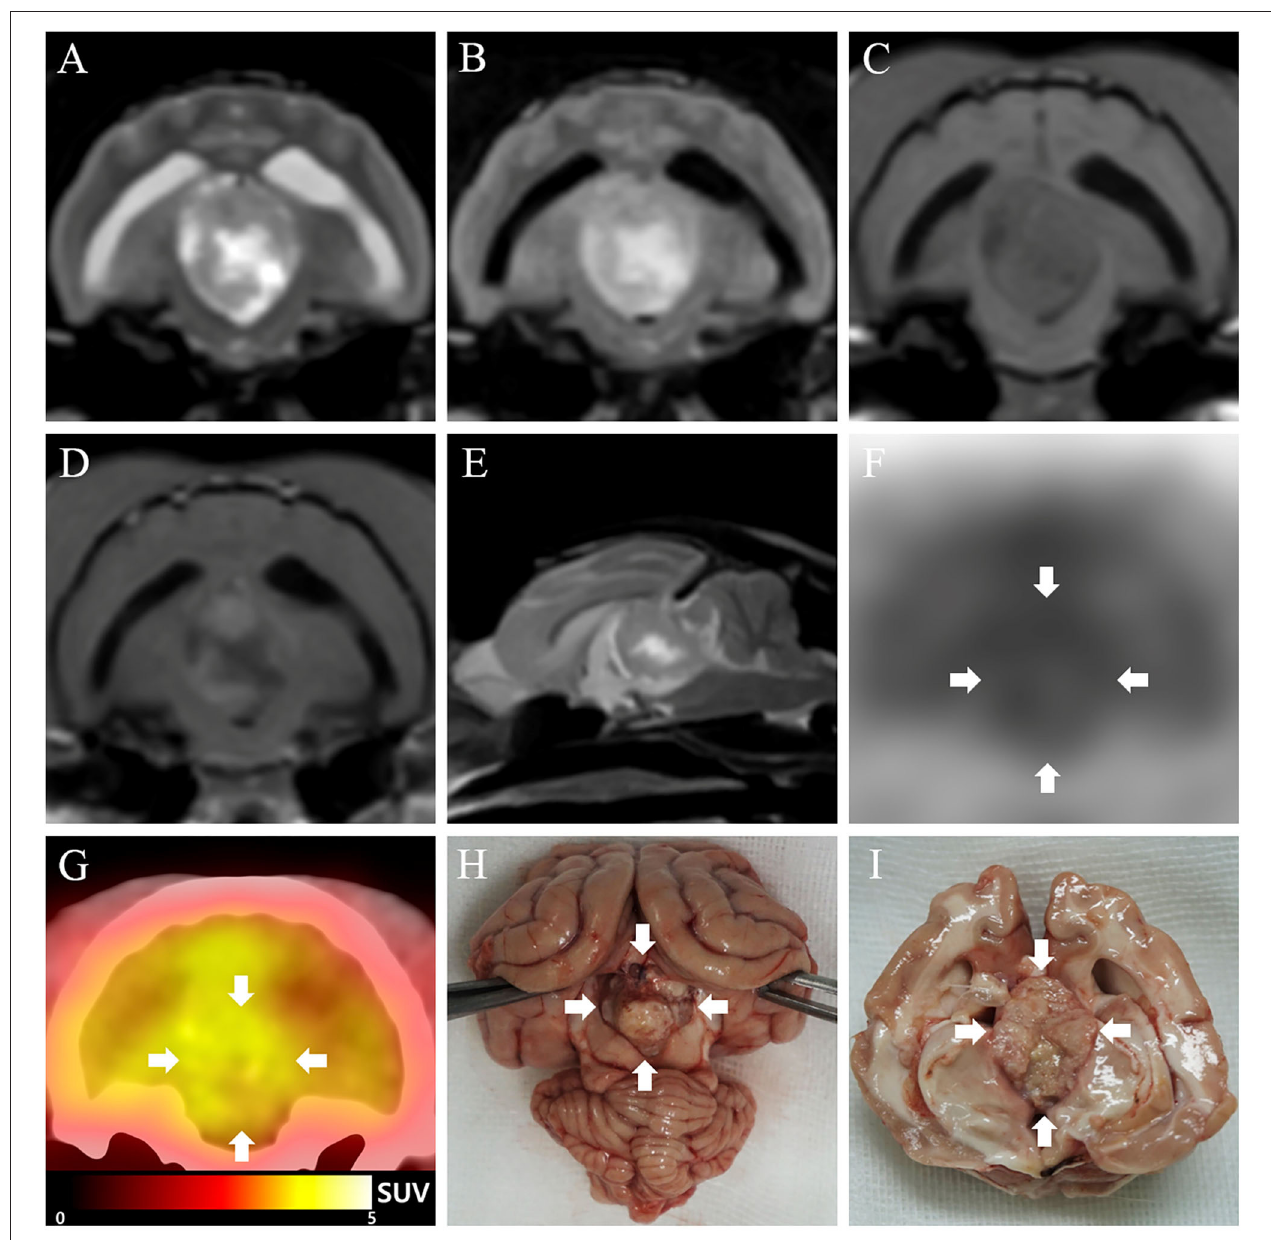
FIGURE 2 | Second magnetic resonance imaging (MRI), 18 F-fluorodeoxyglucose (FDG)-positron emission tomography (PET), and necropsy findings of meningioma in a cat. (A–E) On the second MRI (106 days after the commencement of treatment), the size of the mass appears similar to that measured at the first MRI. (F) On FDG-PET image, high FDG uptake is seen, represented with a black color, while low FDG uptake is represented with a white color. The FDG uptake in the tumor lesion (arrows) is relatively higher than that of the surrounding regions. (G) On PET/computed tomography fusion image, high FDG uptake is represented as yellow color, while low FDG uptake is represented by black to red color. Glucose metabolism in the third ventricle (arrows) is relatively higher than that in the surrounding regions. (H,I) A well-demarcated, oval-shaped mass (arrows) is observed in the third ventricle.